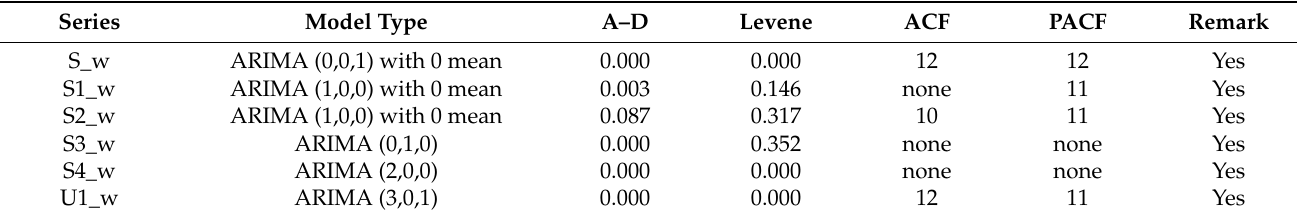
Table 25. Tests of the residuals in ARIMA detrended models for weekly series S_wd, S1_wd, S2_wd, S3_wd, S4_wd, and